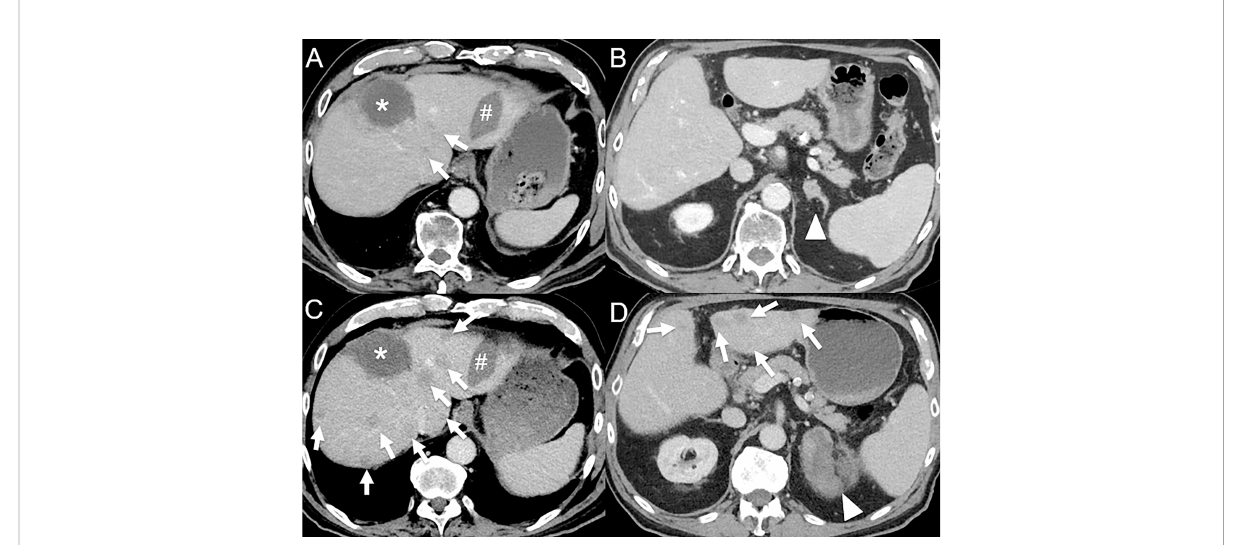
FIGURE 4 Hyperprogression in an 82-year-old male with hepatocellular carcinoma initially treated by selective internal radiation therapy and radiofrequency ablation who develop metastatic disease 11 months post-therapy (bone, left adrenal gland and lung). (A) Baseline contrast-enhanced CT at the portal venous phase shows necrotic lesion treated by selective internal radiation therapy (*) and a radiofrequency ablation scar (#), with 2 small hypodense lesions (arrows). (B) A left adrenal gland metastasis is also seen (arrowhead). The patient was given atezolizumab (anti-PD-L1) and bevacizumab (anti-VEGF). 1-month follow-up contrast-enhanced CT at the portal venous phase shows dramatic disease progression with the appearance of multiple cancer lesions [ (C, D) , arrows] and marked increase in the left adrenal gland metastasis [ (D) ,